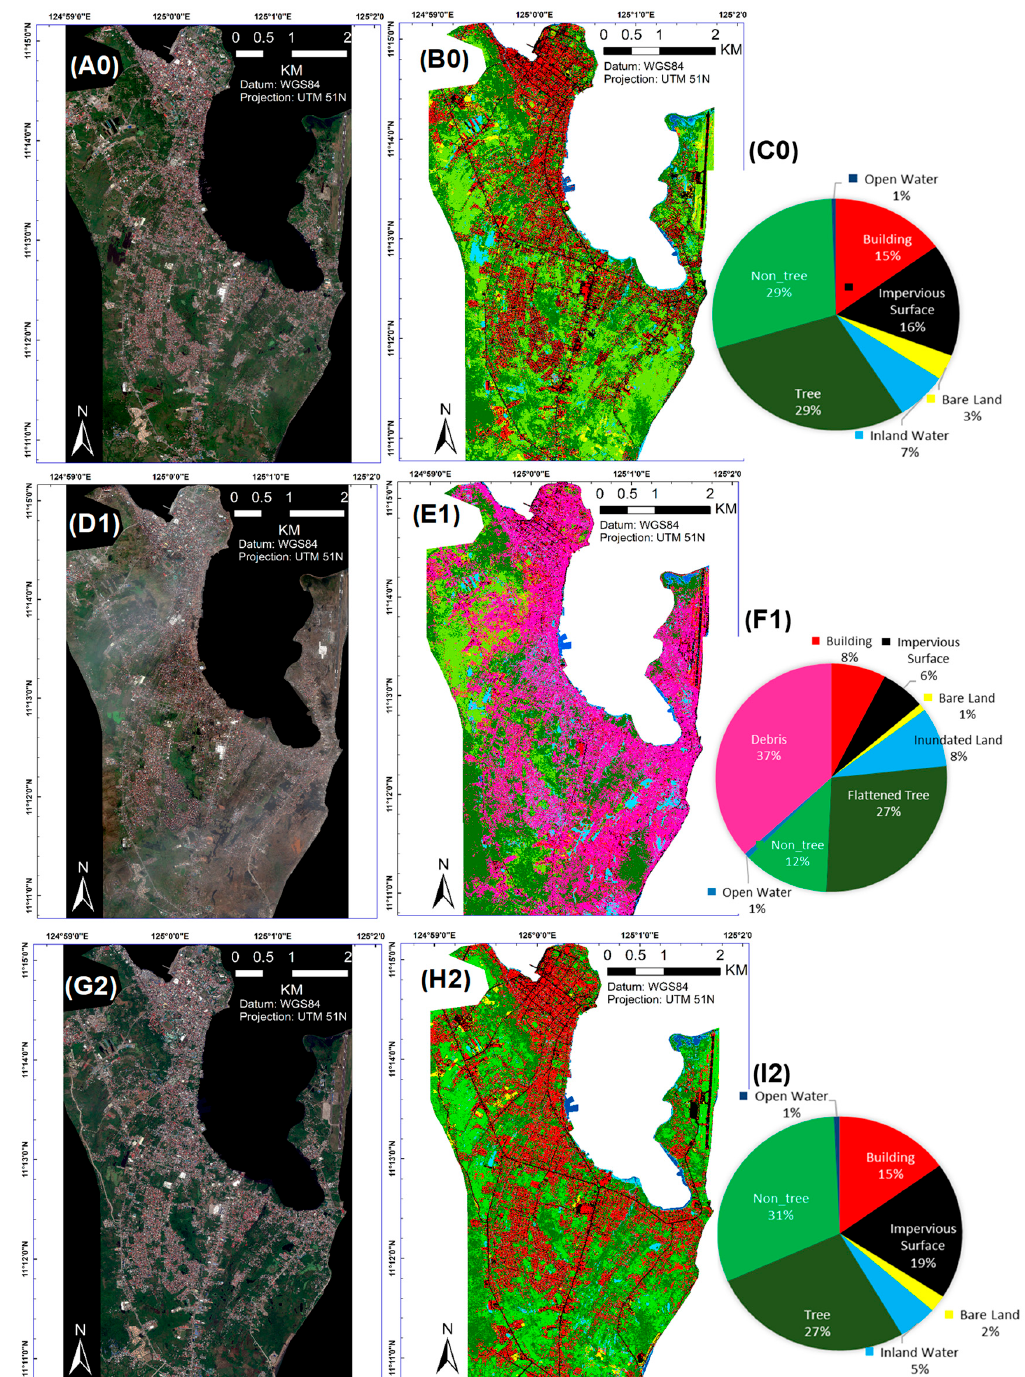
Figure 8. ( A0 ), ( D1 ), ( G2 ): WorldView-2 images acquired over Tacloban city from 8 months before, right after, and 4 years after Typhoon Haiyan, respectively; ( B0 ), ( E1 ), ( H2 ): LC classification maps from SVM relying on GLCM features and NDVI2 for the three-time epoch; ( C0 ), ( F1 ), ( I2 ): Corresponding pie charts show class distribution of LC classes in Tacloban city.